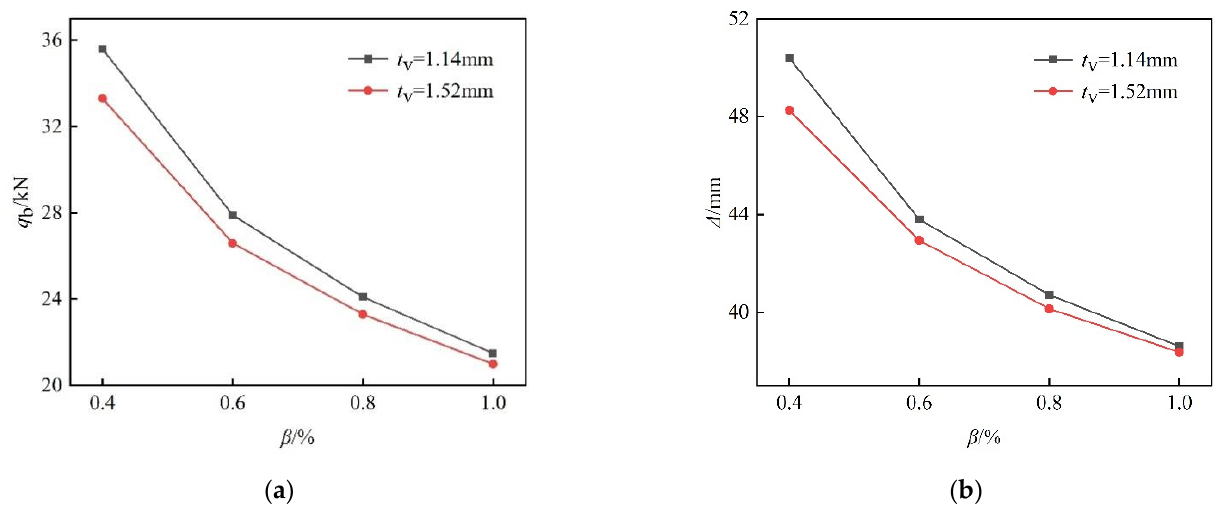
Figure 11. The effect of cold-bending curvature. ( a ) Ultimate capacity curves; ( b ) Ultimate deflection curves.